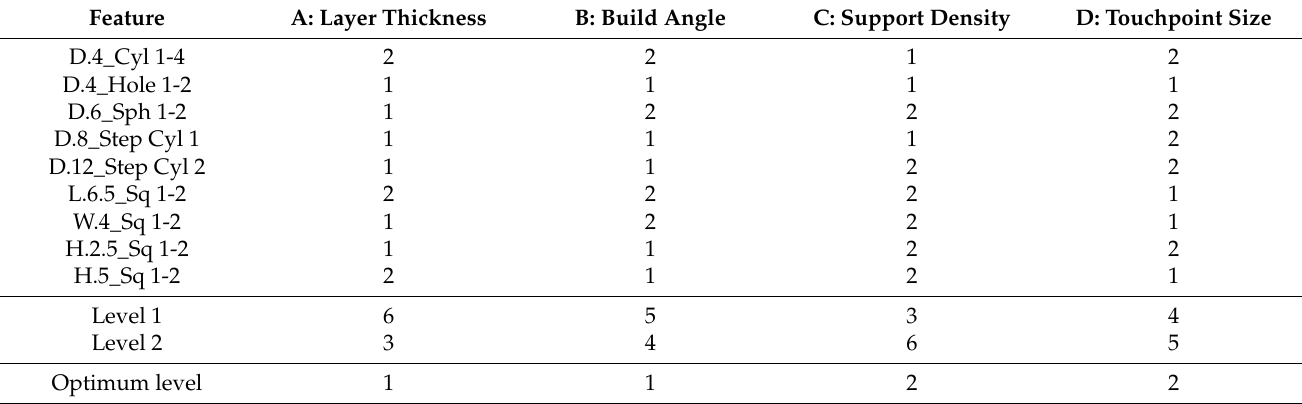
Table 18. Optimum levels of parameters for dimensional accuracy of cast